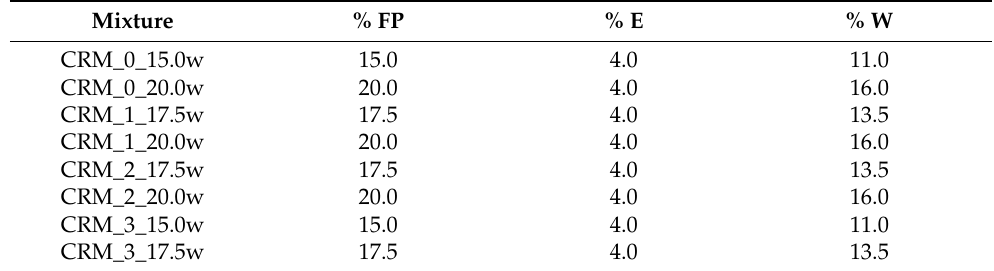
Table 5. Percentages of fluid phase, bituminous emulsion and added water of investigated CRMs.